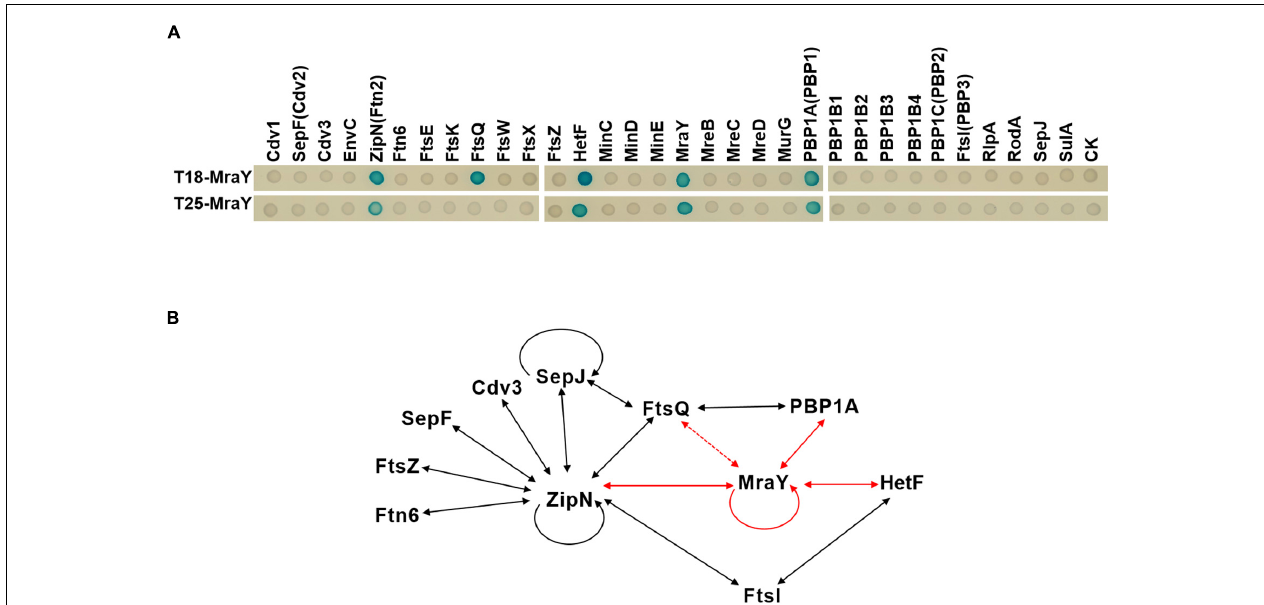
FIGURE 6 | Protein-protein interactions involving MraY determined by bacterial two hybrid assays. (A) Two-hybrid analysis of MraY interaction partners. Interactions of given proteins fused to T25 and T18-MraY (top), or of given proteins fused to T18 and T25-MraY (bottom), were assayed in E. coli by observation of the β -galactosidase activity on agar plates. CK, empty vectors pKT25 or pUT18C. (B) Schematic representation of the web of protein-protein interactions among the 11 presently studied proteins involved in cell division or growth in Anabaena . Solid lines show protein-protein interactions detected with the BACTH system with both fusions of the same protein (in T18 and T25), dotted lines represent interactions detected with only one of the two fusions (either in T18, or T25 alone). The red arrows represent interactions detected in this study. Black arrows correspond to interactions reported elsewhere and further confirmed in the present study. See corresponding text in Results section for more